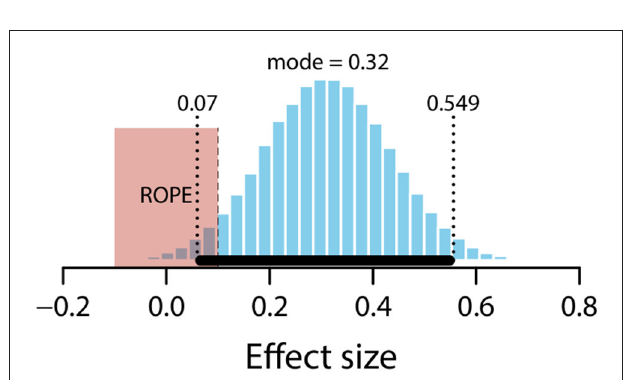
FIGURE 12 | Posterior distribution of effect size for difference between unexpected and null conditions. ROPE from − 0.1 to 0.1. Black bar represents 95% HDI.